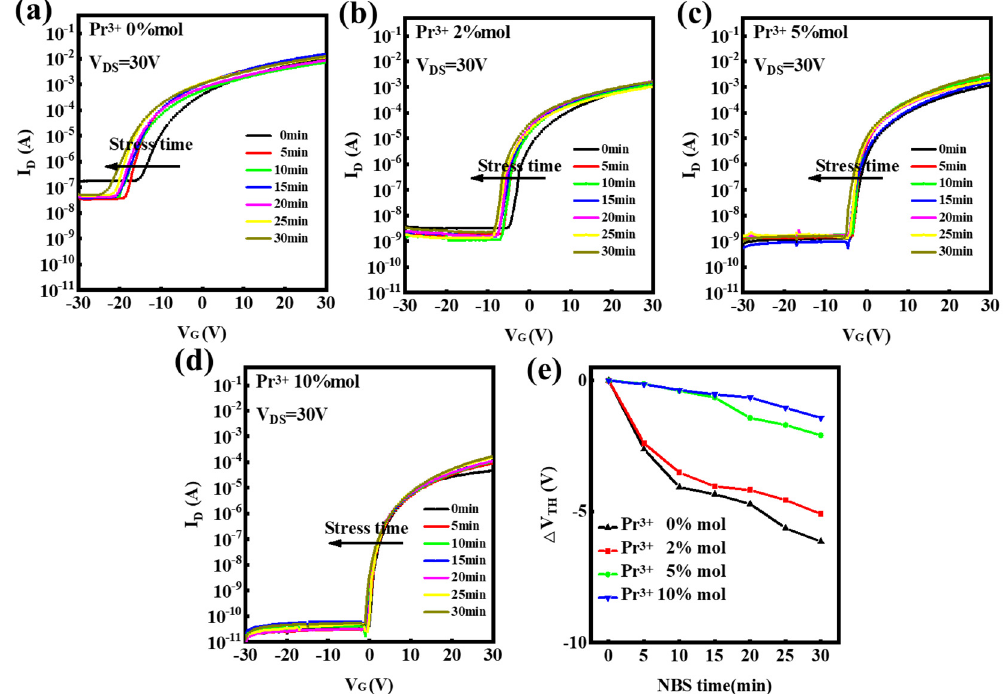
Figure 10. Transfer curves variations under negative bias stress for In-Pr-O TFTs with Pr mol% ratios of ( a ) 0 %, ( b ) 2 %, ( c ) 5 %, ( d ) 10 %, and ( e ) summary of V T shifts.